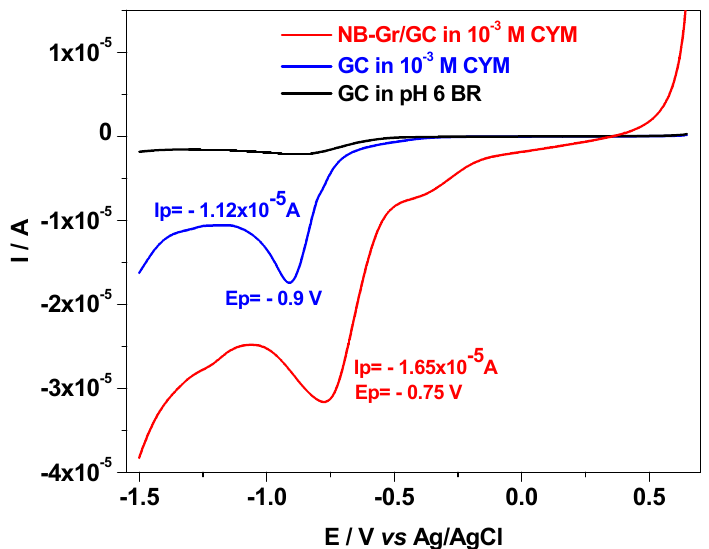
Figure 6. LSVs recorded with NB-Gr/GC electrode (red) and bare GC (blue) in pH 6 BR solution containing 10 − 3 M CYM; GC in pH 6 BR (black); scan rate 10 mV/s. The dependence of cymoxanil peak current on the solution concentration (4 × 10 − 5 –10 − 3 M) was measured under the optimized conditions (pH 6 BR) and is presented in Figure 7a,b. As revealed by this figure, the peak current constantly increased with CYM concentration, and the corresponding calibration plot has the linear regression equation expressed by: |I p | = 6.94 × 10 − 9 + 0.0134 × C CYM (R 2 = 0.998). The limit of quantification (LOQ) was determined to be 4 × 10 − 5 M, while the limit of detection (LD) was 1.21 × 10 − 5 M. The modified electrode was also tested for successive measurements and it proved to have a good reproducibility. Between the measurements the electrode was immersed in a mixture of methanol: distilled water for 30 min, then cycled in pH 6 BR until no signal from CYM was observed (about 20 cycles; scan rate 50 mV/s).